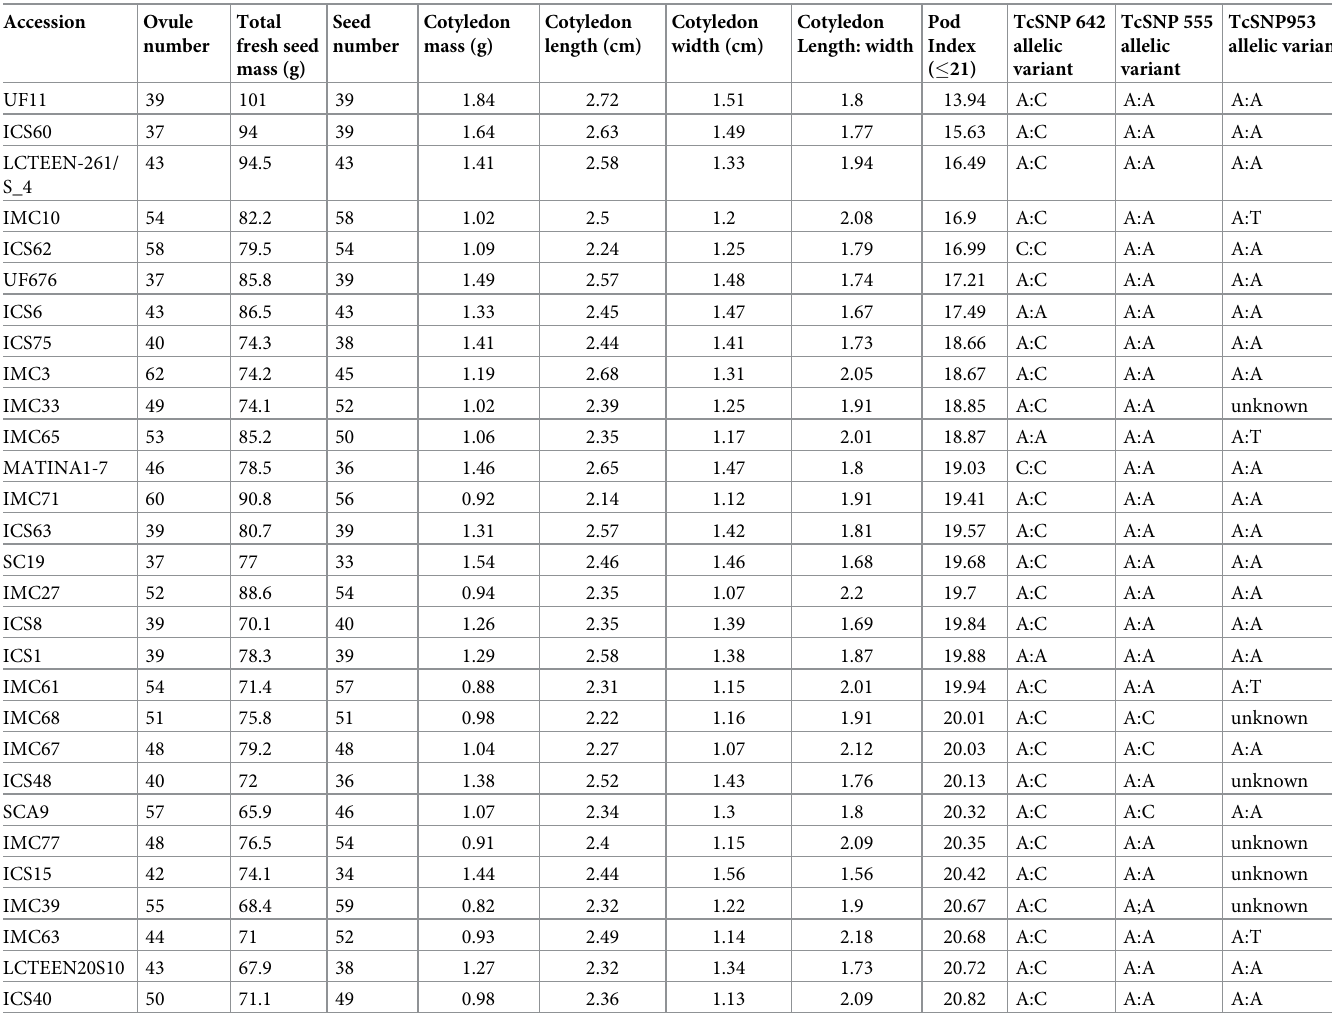
Table 5. Superior accessions in terms of yield-related traits and associated genotypes (allelic variants) for SNP markers of